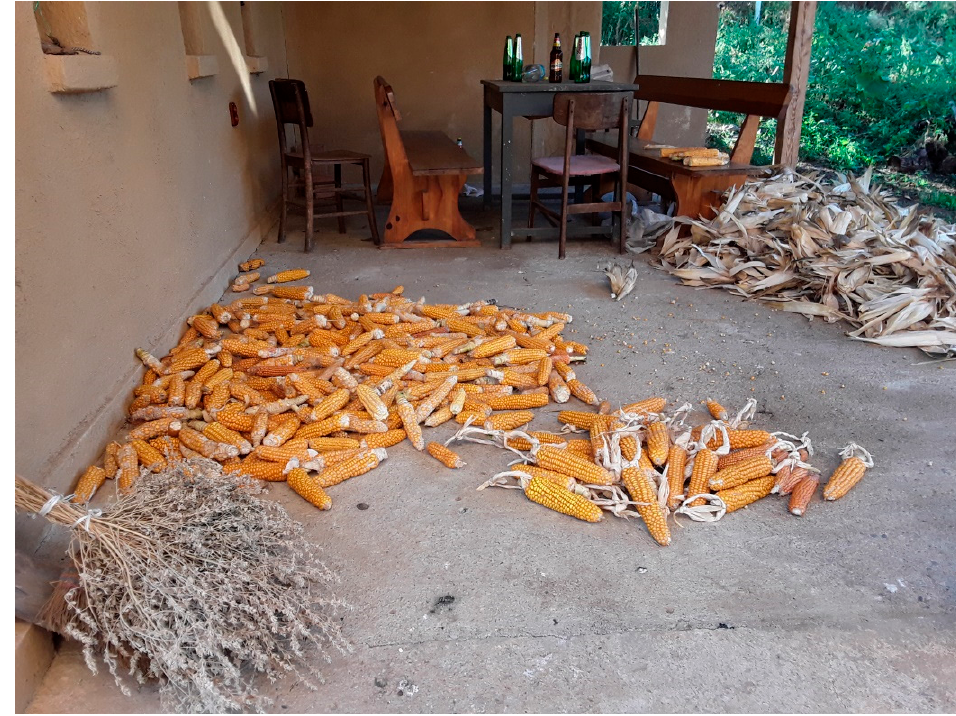
Figure 6. Home yard broom made of Marrubium peregrinum L. Table 4. Sources of Lamiaceae taxa used in rural Bulgaria.